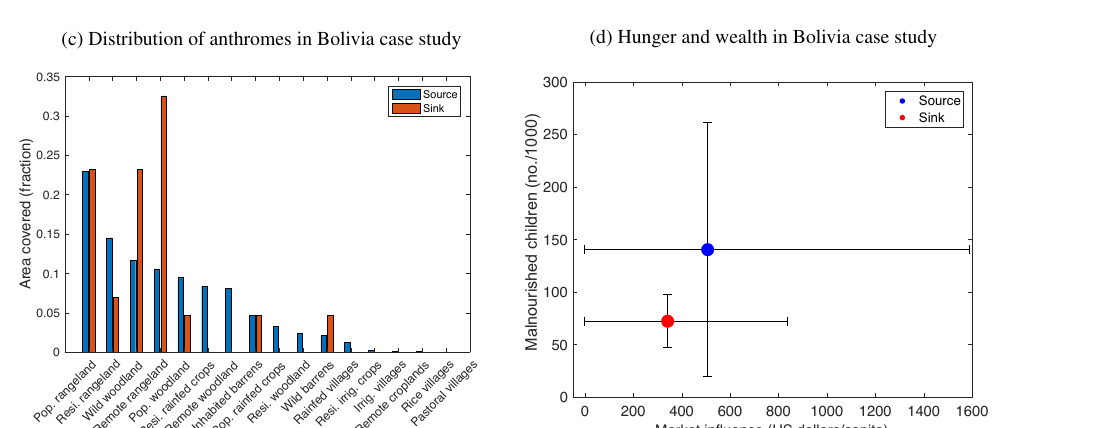
Note: The shaded region depicts the 1mm precipitationshed and contains 96.5 % of mean annual precipitation falling in the sink region.